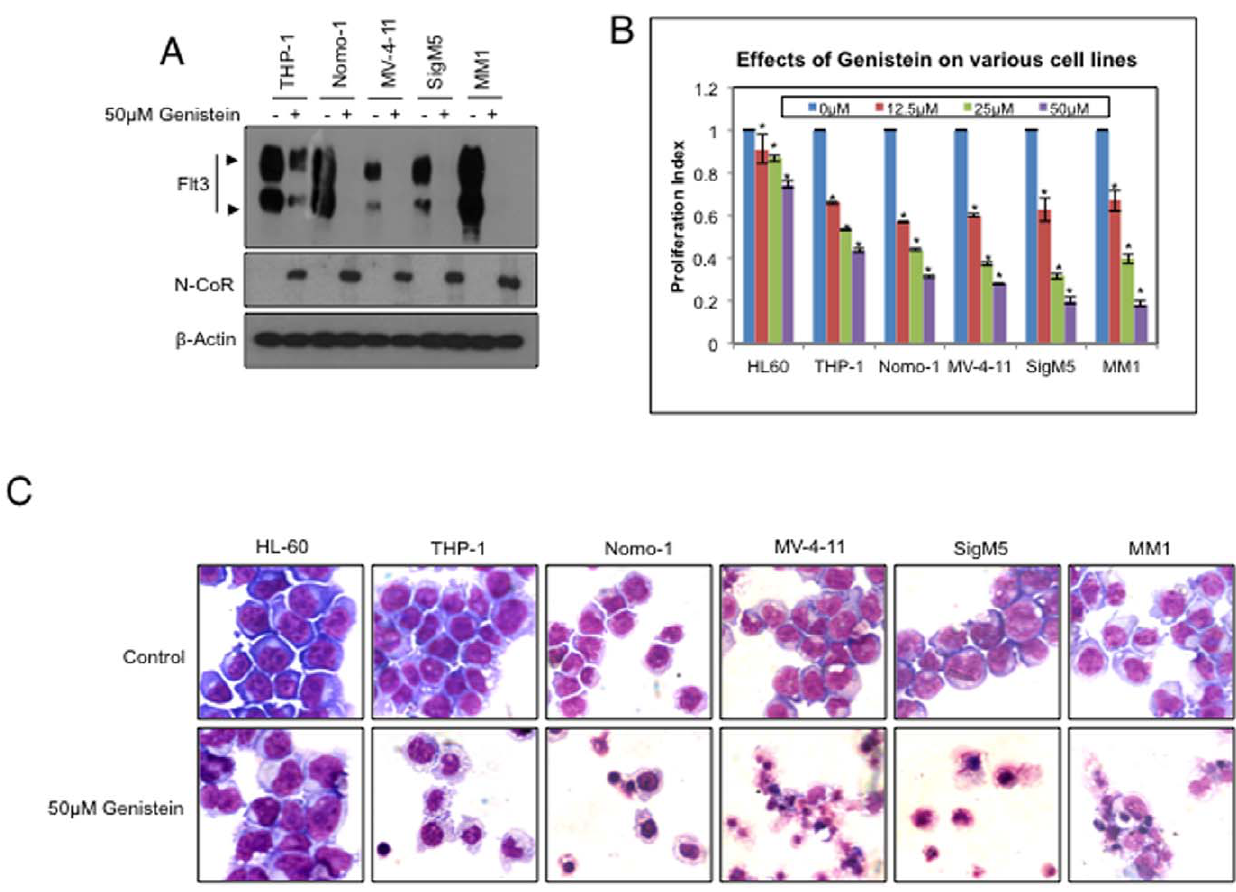
Figure 6. Restoration of N-CoR function attenuates the proliferative properties of AML-M5 cells regardless of the Flt3 receptor mutational status. A , Genistein stabilized N-CoR in all 5 AML-M5 cell lines at 50 m M with a concurrent down-regulation of the Flt3 receptor expression as determined via western blotting. B , Restoration of N-CoR function in AML-M5 cells attenuated the proliferative potential of AML-M5 cells. Proliferative capacity of N-CoR positive AML cells HL-60 and N-CoR negative AML-M5 cells after treatment with Genistein at 72 hours was determined via growth proliferation assay (MTT). Growth inhibition was most pronounced at 50 m M in AML-M5 cells while at the same dose, growth inhibitory effects on N-CoR positive HL-60 was less pronounced. Results are representative of 3 independent experiments and asterisks represent p , 0.05. C , Morphology of N-CoR positive HL-60 and N-CoR null AML-M5 cells (THP-1, Nomo-1, MV-4-11, SigM5, MM1) as determined via Wright- Giemsa staining after treatment with 50 m M Genistein for 72 hours.